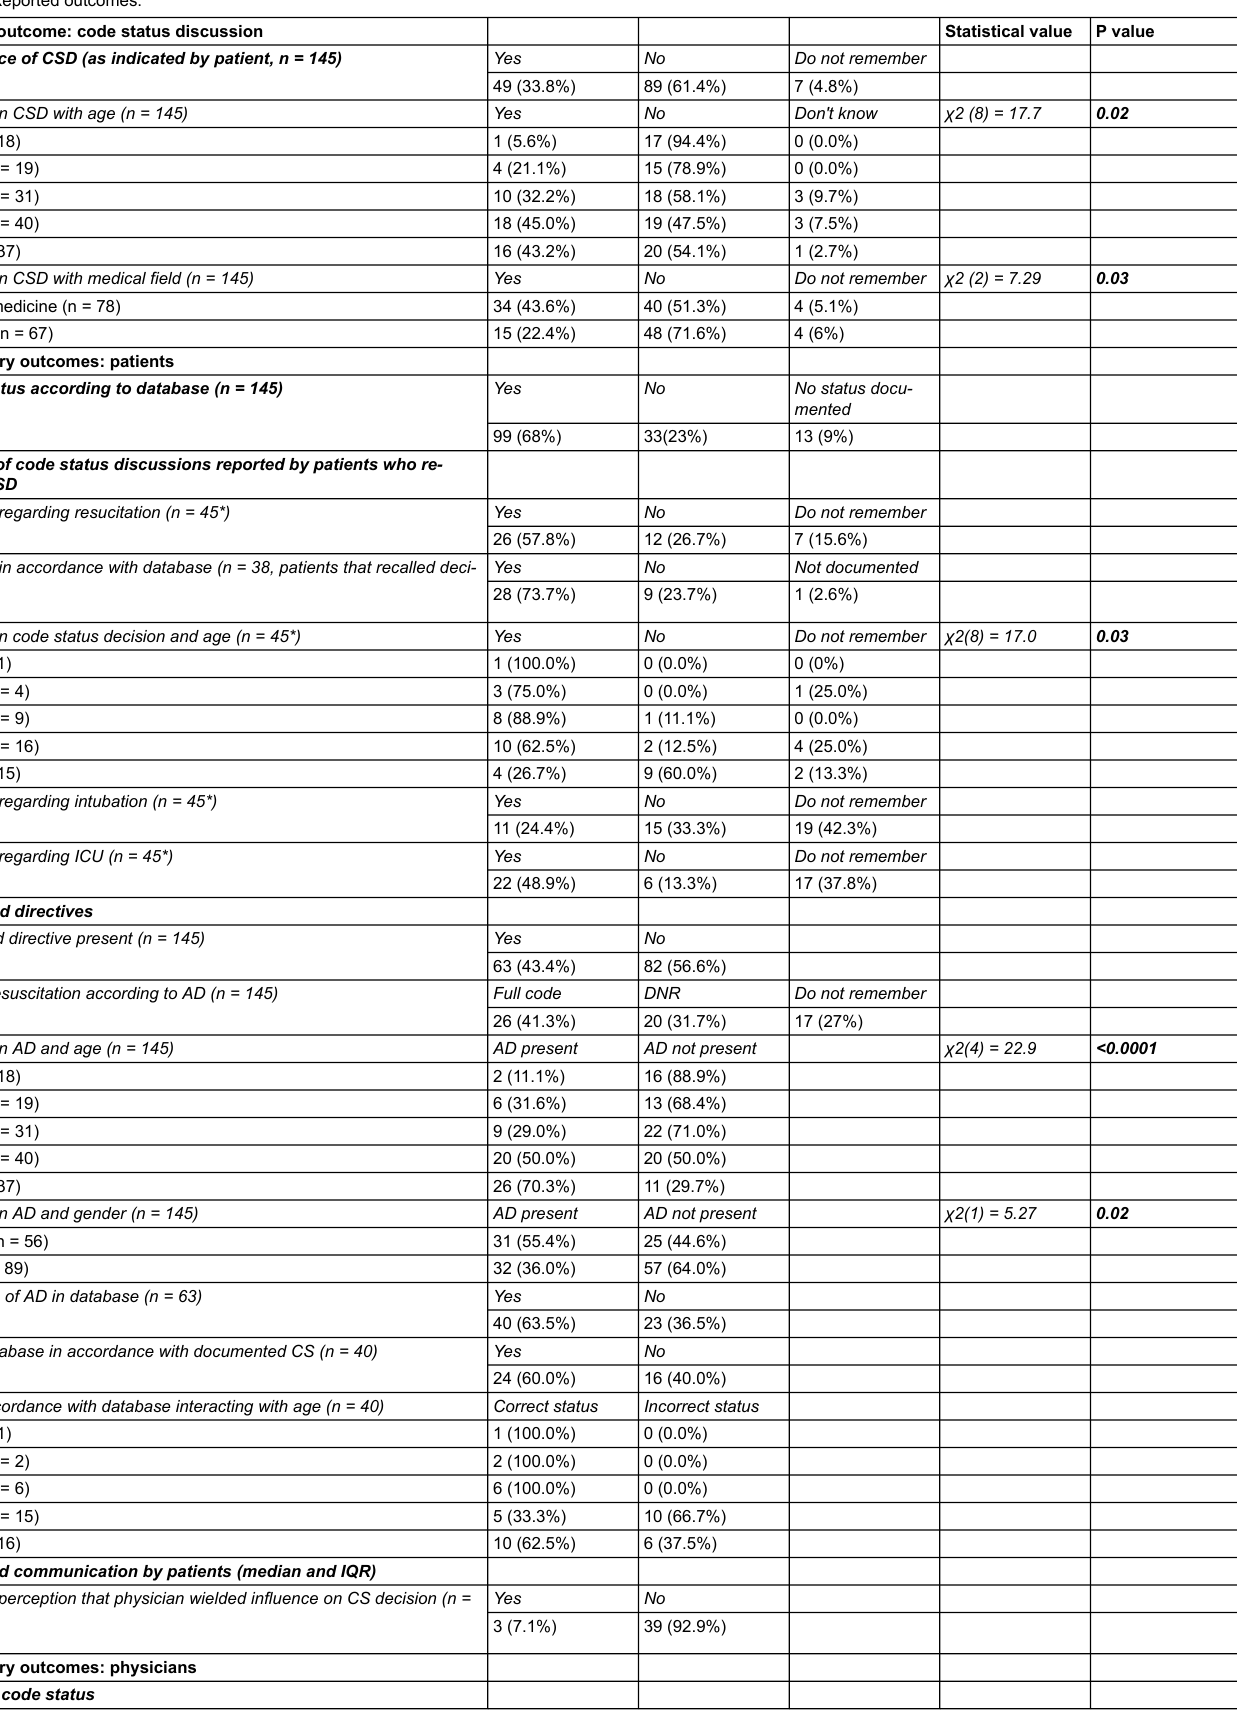
Table 2: Reported outcomes. Primary outcome: code status